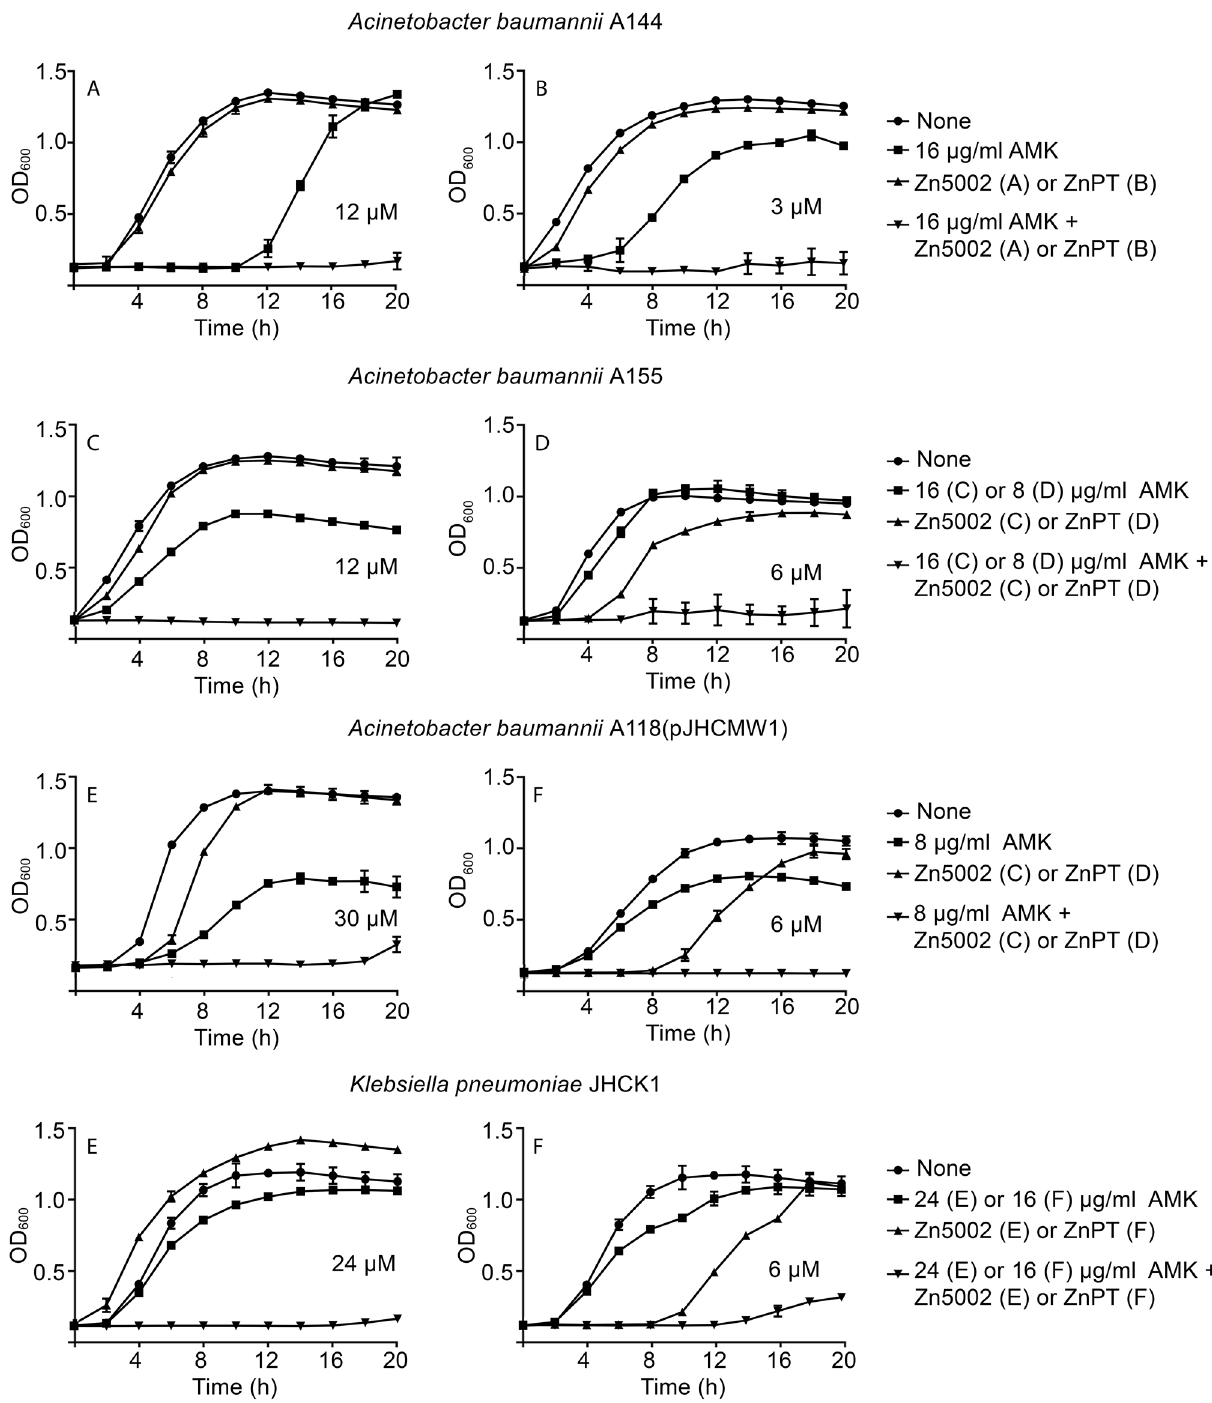
Figure 2. Effect of Zn5002 and ZnPT complexes on resistance to amikacin. A . baumannii A155, A144, A118(pJHCMW1), or K. pneumoniae JHCK1 were cultured in 100 μl Mueller–Hinton broth in microtiter plates at 37 °C with the additions indicated to the right of each panel, and the OD 600 was periodically measured. All cultures contained 0.5% DMSO. AMK,